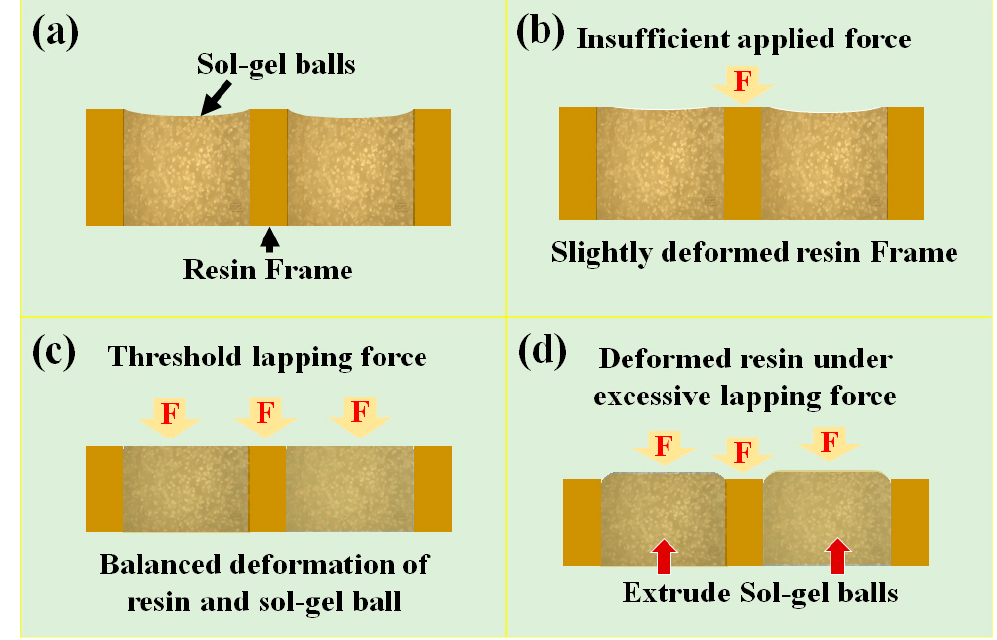
Figure 10. Illustration of the deformation of composite lapping plates with sol–gel balls embedded in resin frame: ( a ) as-prepared, ( b ) under a relatively small lapping force, ( c ) with balanced deformation under a threshold lapping force, and ( d ) with extrusion of sol–gel balls under excessive lapping force.